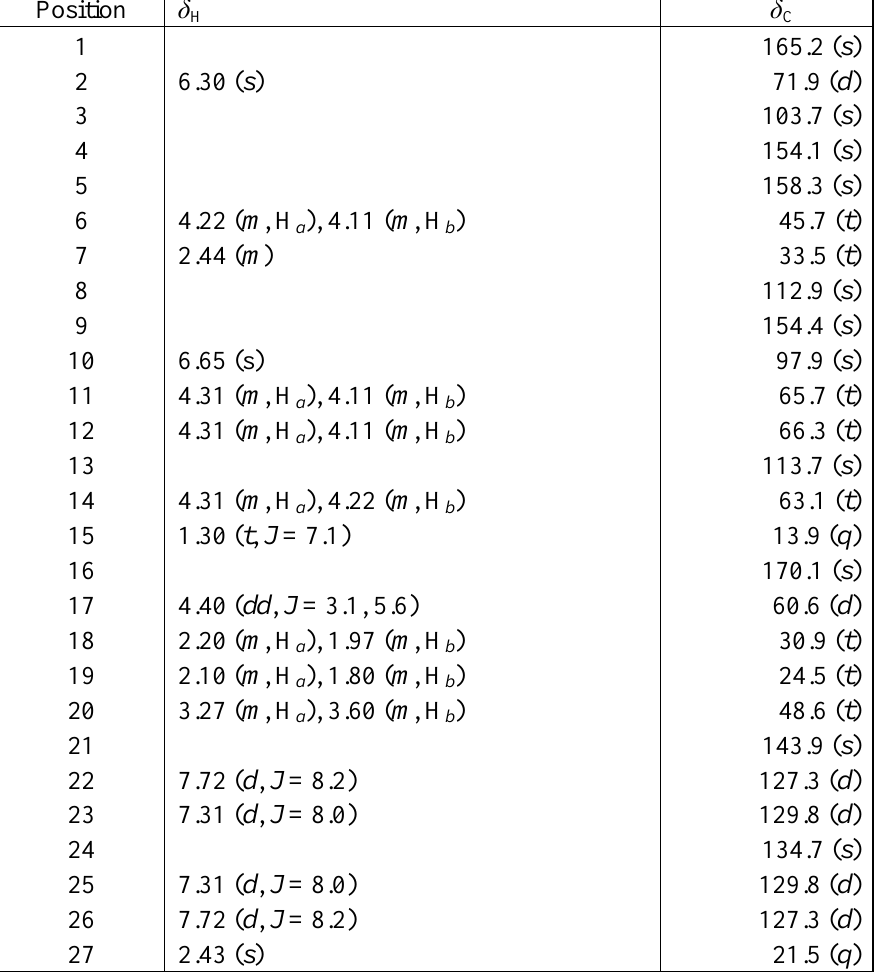
; δ in ppm, J in 3